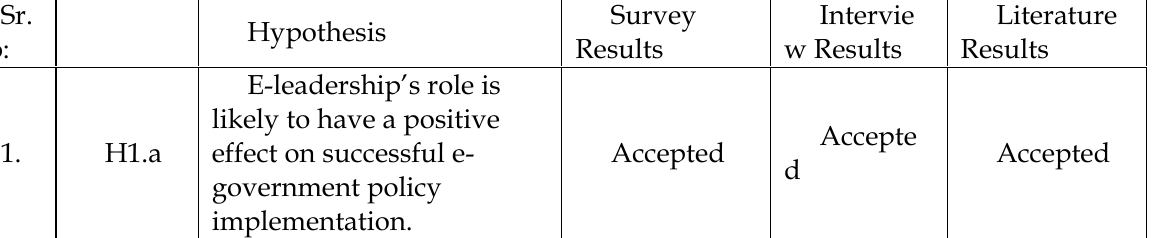
Table 4: Results